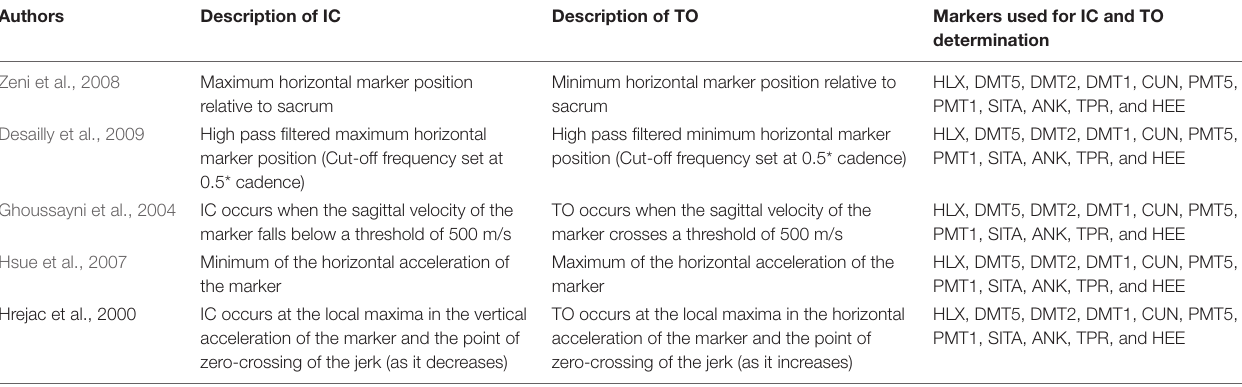
TABLE 2 | Definition of gait events (IC, TO) according to included